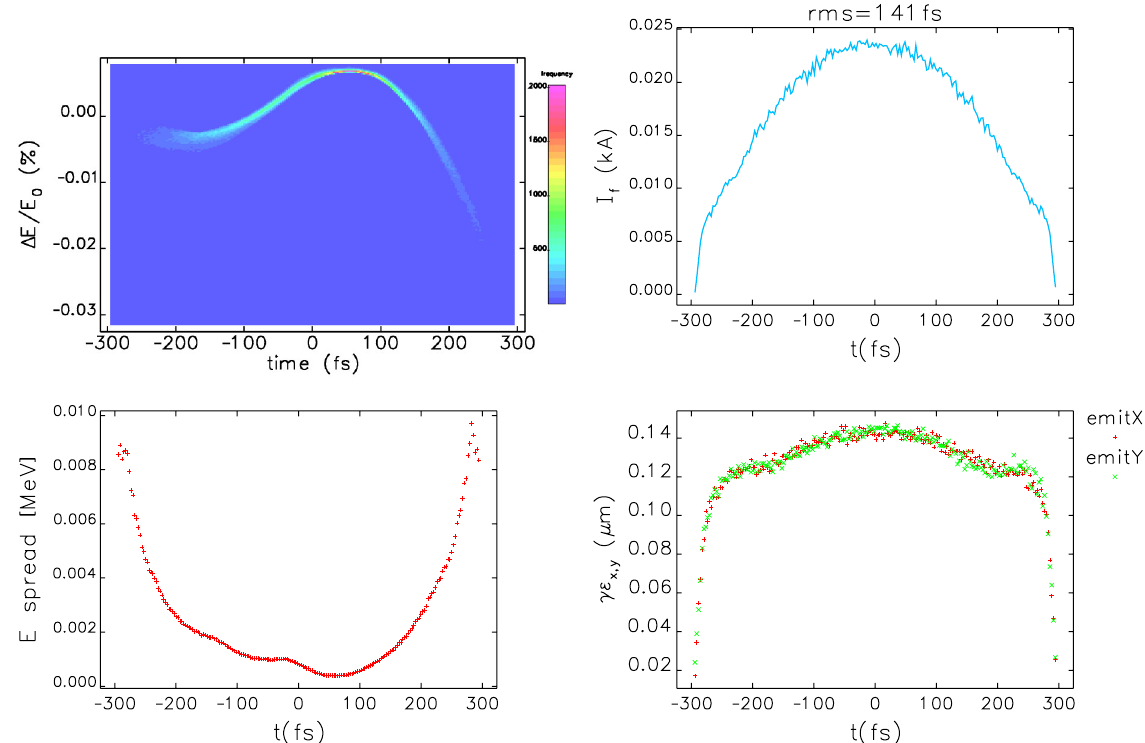
FIG. 2. Electron beam properties at the end of Linac0 (see Fig. 1), with a beam energy of 54 MeV. Left top: longitudinal phase space; left bottom: longitudinally sliced energy spread; right top: current profile; right bottom: longitudinally sliced emittance. A normalized transverse emittance of 0 : 14 (cid:1) m is achieved for a bunch charge of 10 pC, with an rms bunch length of 42 (cid:1) m . The longitudinal distribution of this electron bunch follows a hyperbolic shape, with a relative slice energy spread of 2 (cid:1) 10 (cid:2) 5 .